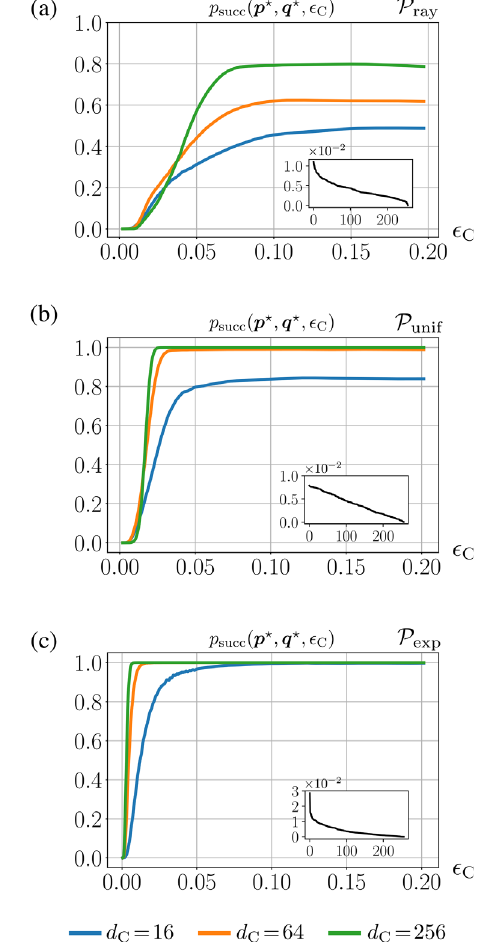
Algorithm 1. Estimating p